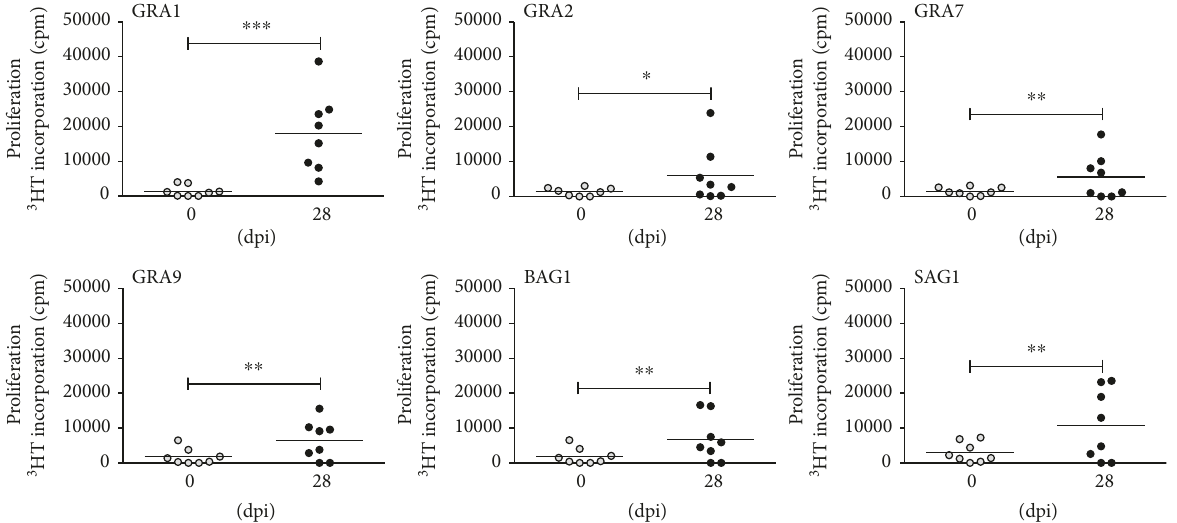
Figure 2: T cell proliferation after stimulation with recombinant antigens from T. gondii . 1.5 × 10 5 PBMC/well from 8 pigs before infection (0 dpi) and day 28 post infection (28 dpi) were stimulated in triplicate with recombinant GRA1, GRA2, GRA7, GRA9, BAG1, or SAG1 (1 μ g/ml) and T cell proliferation was determined via 3 H-thymidine incorporation. Each dot represents one individual; black bars indicate mean counts per minute from all individuals tested; signi fi cant di ff erences are marked with asterisks ( ∗ p ≤ 0 05 , ∗∗ p ≤ 0 01 , and ∗∗∗ p ≤ 0 0001